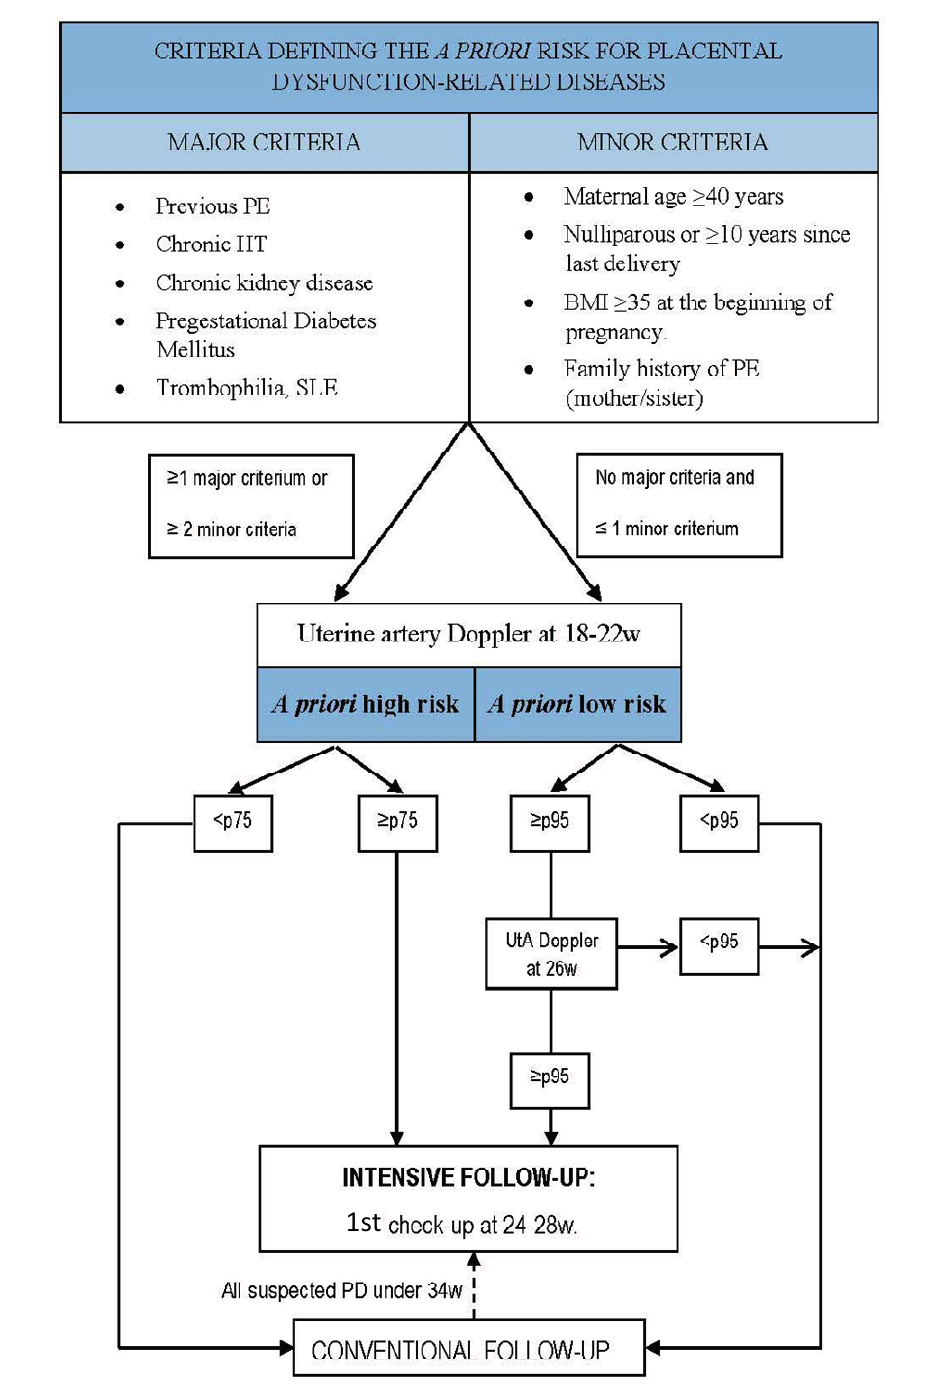
Figure 2. Algorithm for the selection of patients at risk of developing placental dysfunction-related diseases. BMI, body mass index (kg/m 2 ); HT, hypertension; p, percentile; PE, preeclampsia; PD, placental dysfunction; UtA, uterine arteries; w, weeks of